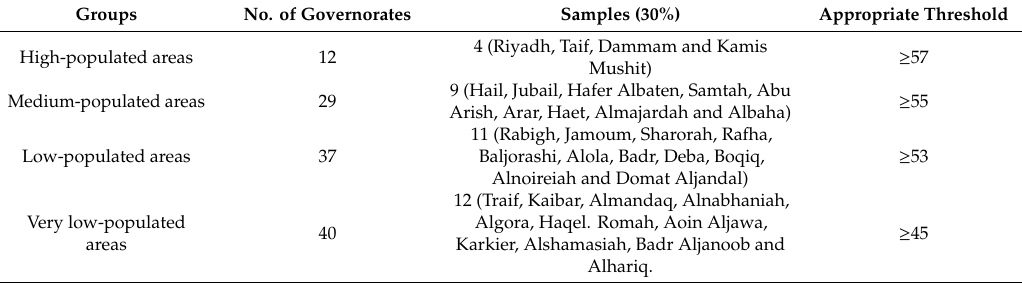
Table 3. Appropriate thresholds in Saudi